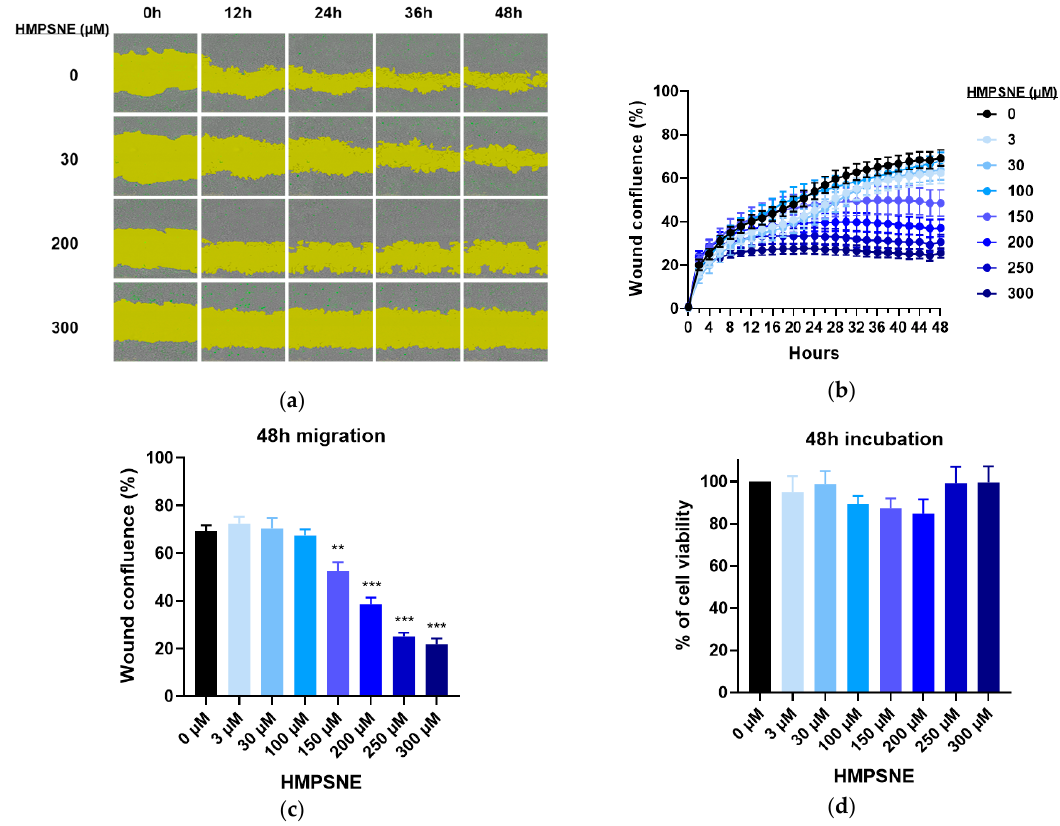
Figure 8. Scratch wound CT26 migration assay with 3-MST inhibitor: ( a ) Representative images taken with Incucyte 10x showing wound area (yellow) coverage by cells and real-time cell death (green) every 12h for 48h; ( b ) Representatives curves of wound confluence in percentage over time with serial dilutions of HMPSNE. Data are presented as mean ± SEM of three replicates per condition; ( c ) Wound confluence in percentage after 48 h. Data are presented as mean ± SEM of three independent replicates per condition, and Dunnett’s multiple comparisons tests are shown vs. 0 µM (* p < 0.05, ** p < 0.01, *** p < 0.001); ( d ) Cell viability after 48 h migration, assessed by the fluorescence of cyanine nucleic acid dye. Data are presented as mean ± SEM of three